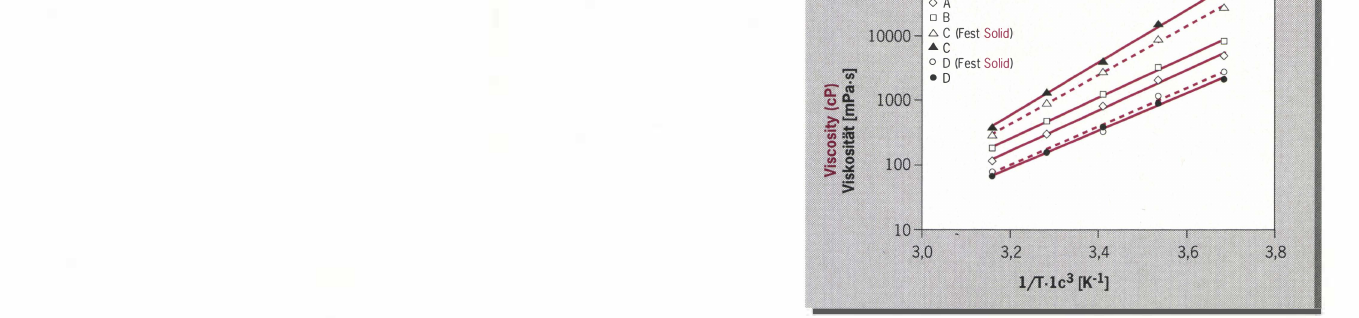
Fig. 2: Arrhenius plots of 3 % aqueous solutions